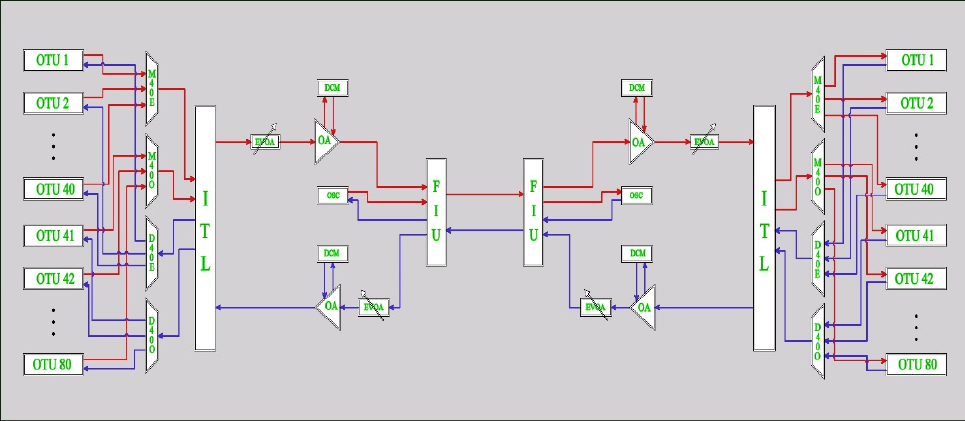
Figure 1. The ultra-high speed data transmission optical system structure by implementing an 80- channel DWDM system. 80-channel DWDM